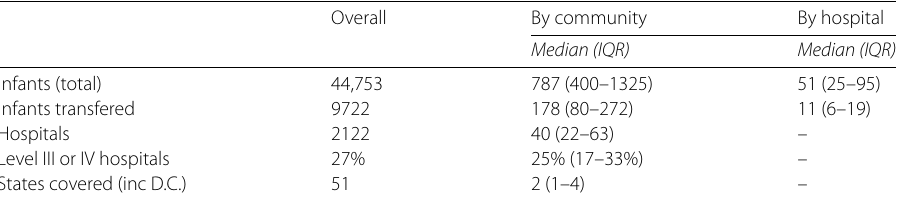
Table 1 Hospital and community characteristics with the interquartile range (IQR), i.e. the interval between the 25th and 75th percentiles Overall By community By hospital Median(IQR) Median(IQR) Infants (total) 44,753 787 (400–1325) 51 (25–95) Infants transfered 9722 178 (80–272) 11 (6–19) Hospitals 2122 40 (22–63) 27% 25% (17–33%) 51 2 (1–4)